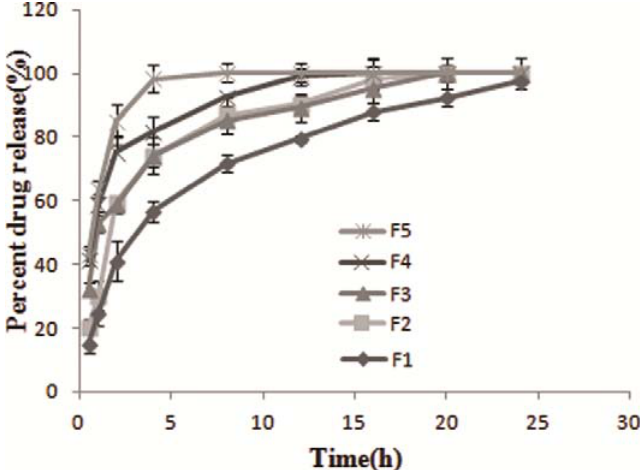
Figure 2. Release profile from berbeine SA